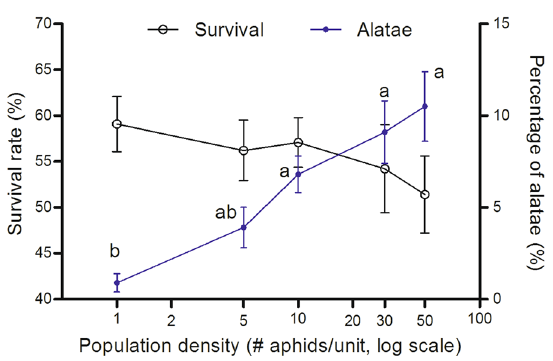
Figure 3. Maternal crowding effect on offspring survival and alatae of Rhopalosiphum maidis . Different letters indicate significant differences ( P < 0.05) by using Tukey’s multiple range